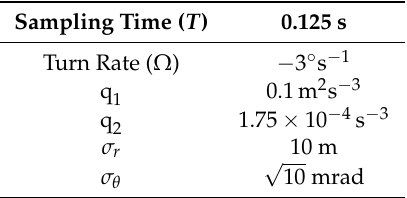
Table 4. Parameters used in tracking